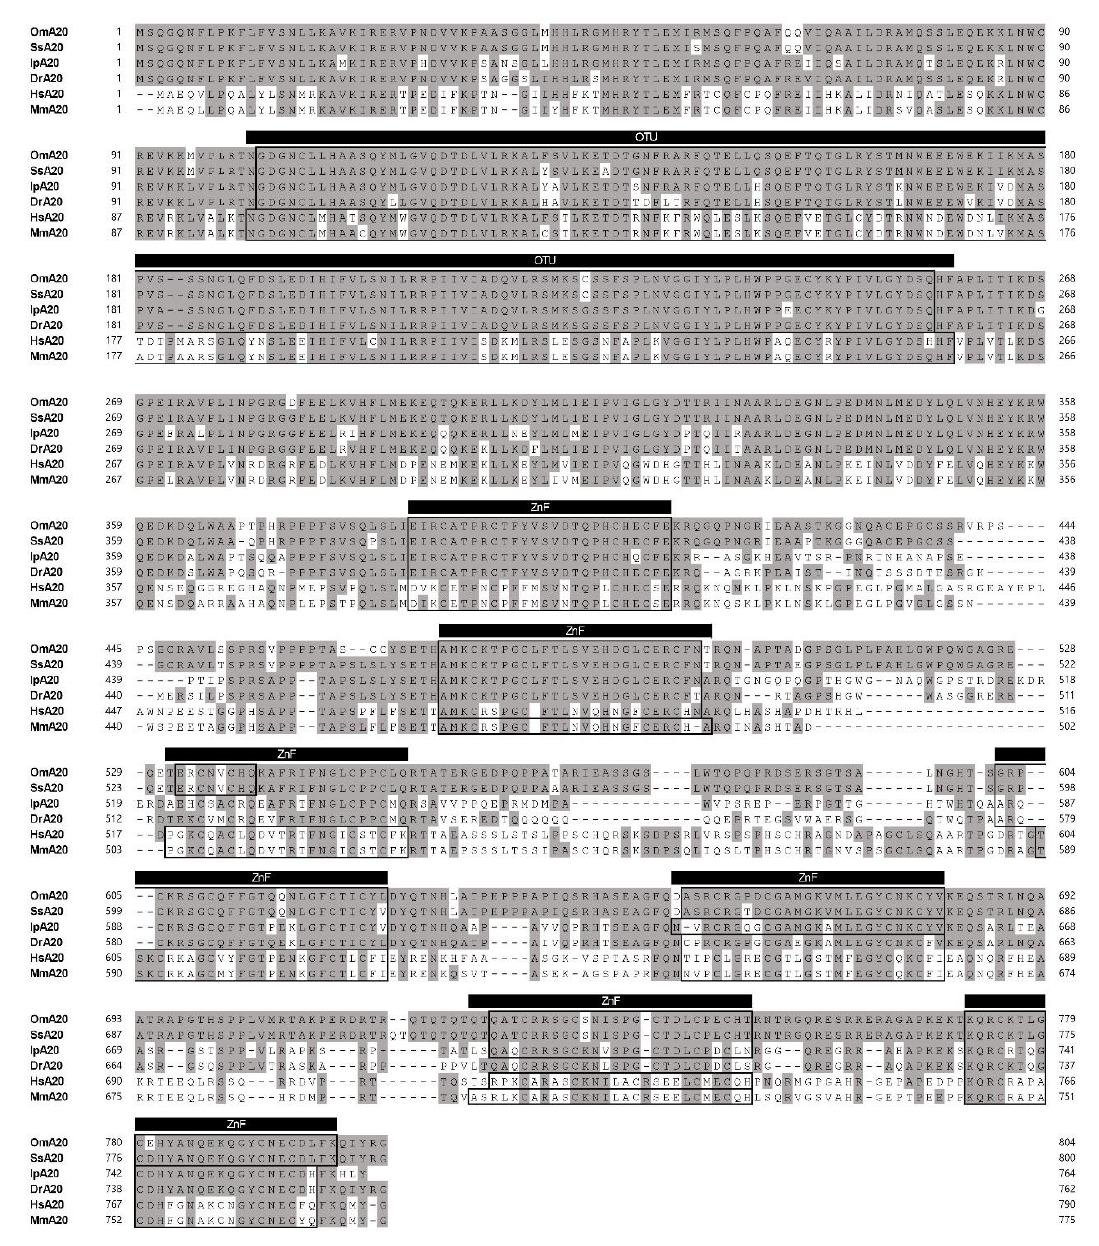
Figure 1. Multiple alignments of deduced amino acid sequences of rainbow trout A20 ( Oncorhynchus mykiss , Om) with those of Atlantic salmon ( Salmo salar , Ss), channel catfish ( Ictalurus punctatus , Ip), zebrafish ( Danio rerio , Dr), human ( Homo sapiens , Hs), and mouse ( Mus musculus , Mm). Identical amino acids are shaded grey. OTU and ZnF domains predicted by SMART program are indicated as black bars above the alignment.